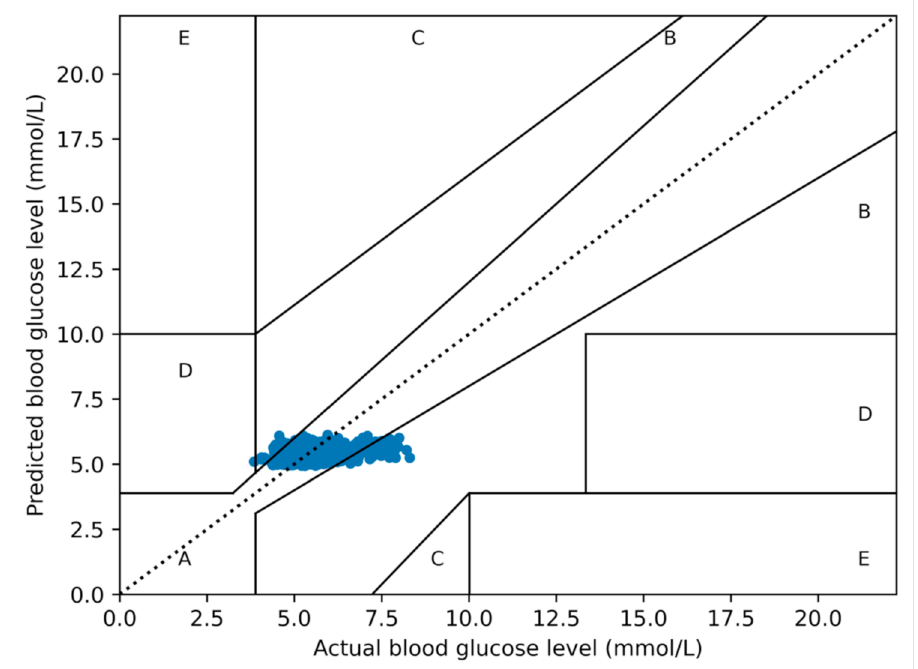
Figure 16. The EGA diagram for the RG_LightGBM model.